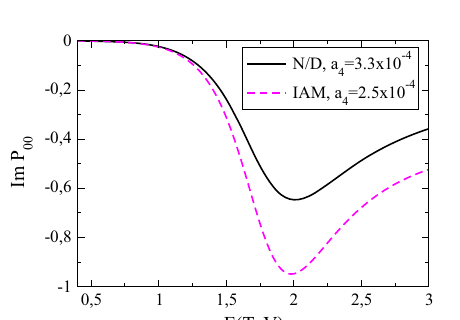
Fig. 8 Comparison of the IAM and N/D methods. The LO parameters are a = 0 . 81, b (cid:3) a 2 ; the only non-vanishing NLO parameter at μ = 3 TeV is a 4 as indicated for each of the two lines